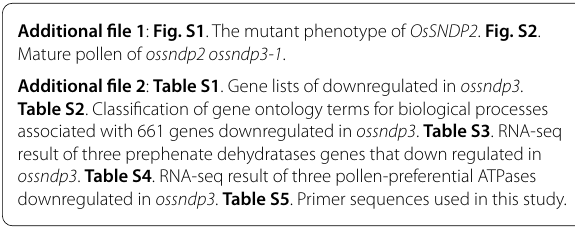
ossndp3 . Table S4 . RNA‑seq result of three pollen‑preferential ATPases downregulated in ossndp3 . Table S5 . Primer sequences used in this